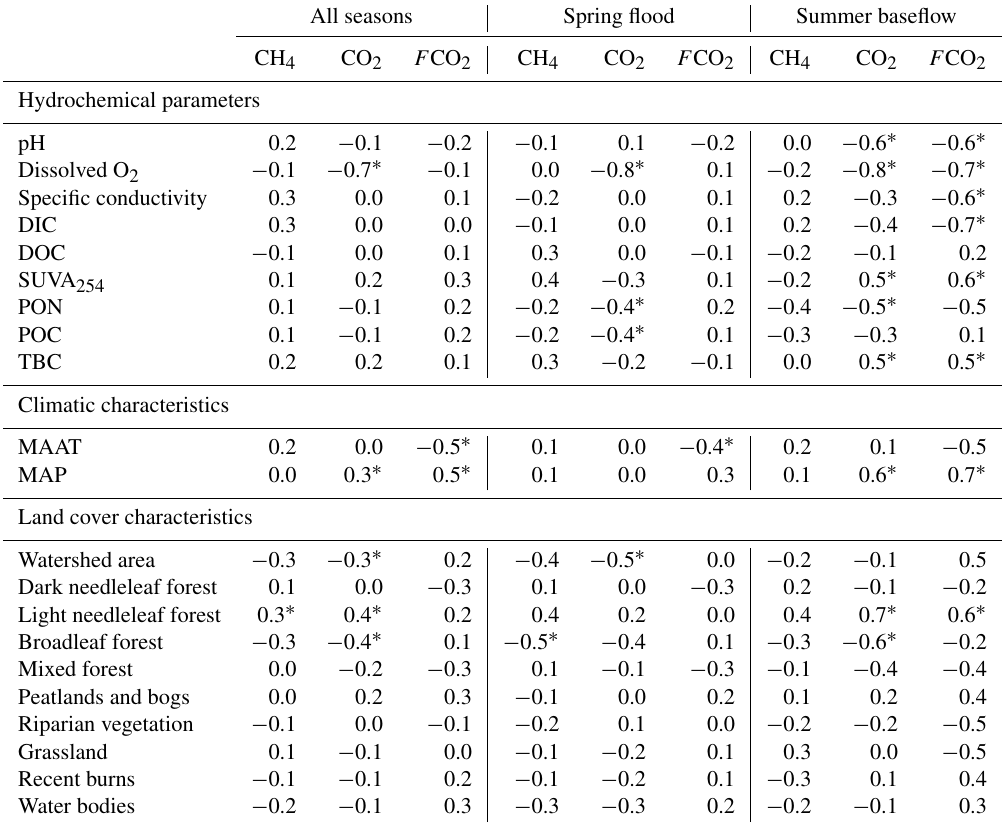
Table 2. Pearson correlation coefficients of measured F CO 2 , CO 2 , and CH 4 concentrations with hydrochemical parameters of the water column (DOC, SUVA, particulate organic carbon and nitrogen, total bacterial cells) and landscape parameters of the tributaries and the main stem of the Ket River. Significant ( p< 0 . 05) values are labeled with